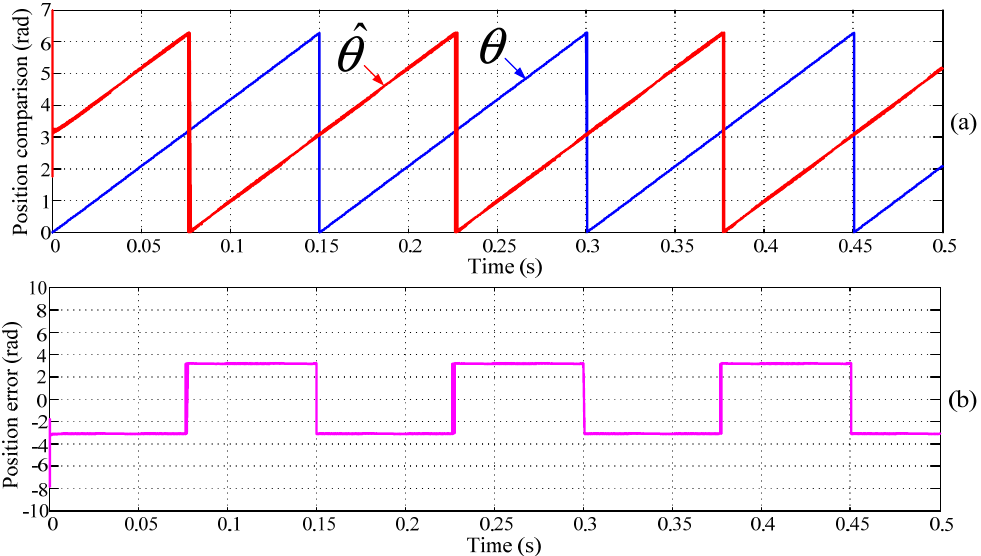
θ θ ) and rotor angle ) and rotor angle